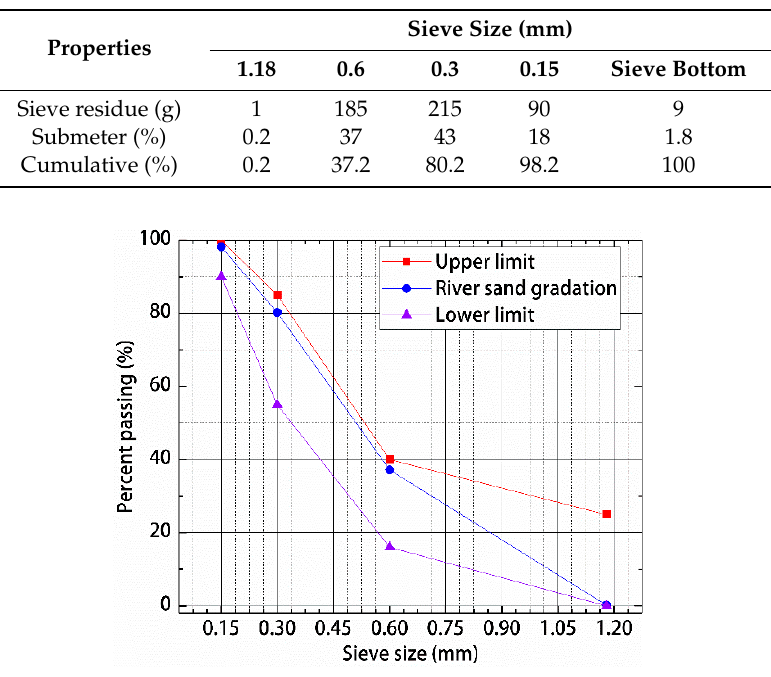
Table 5. River sand screening results.